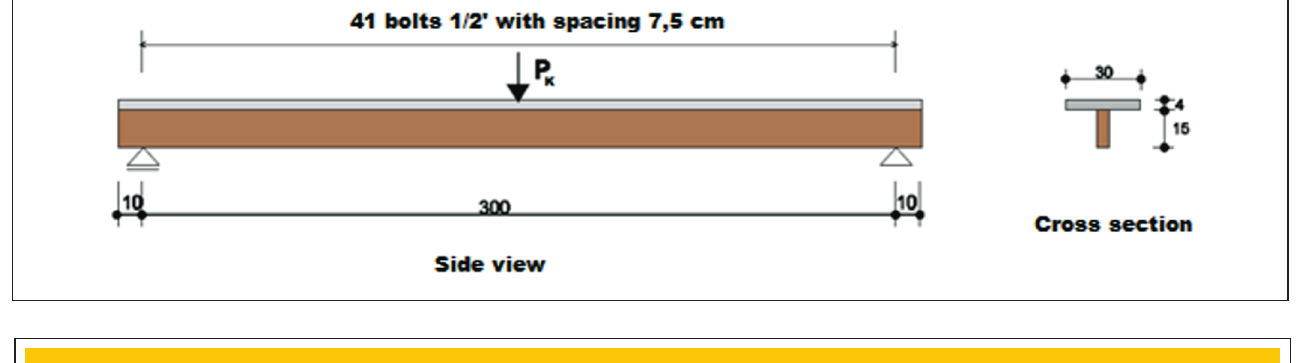
Figure 9 – Boundary conditions of the tested beams